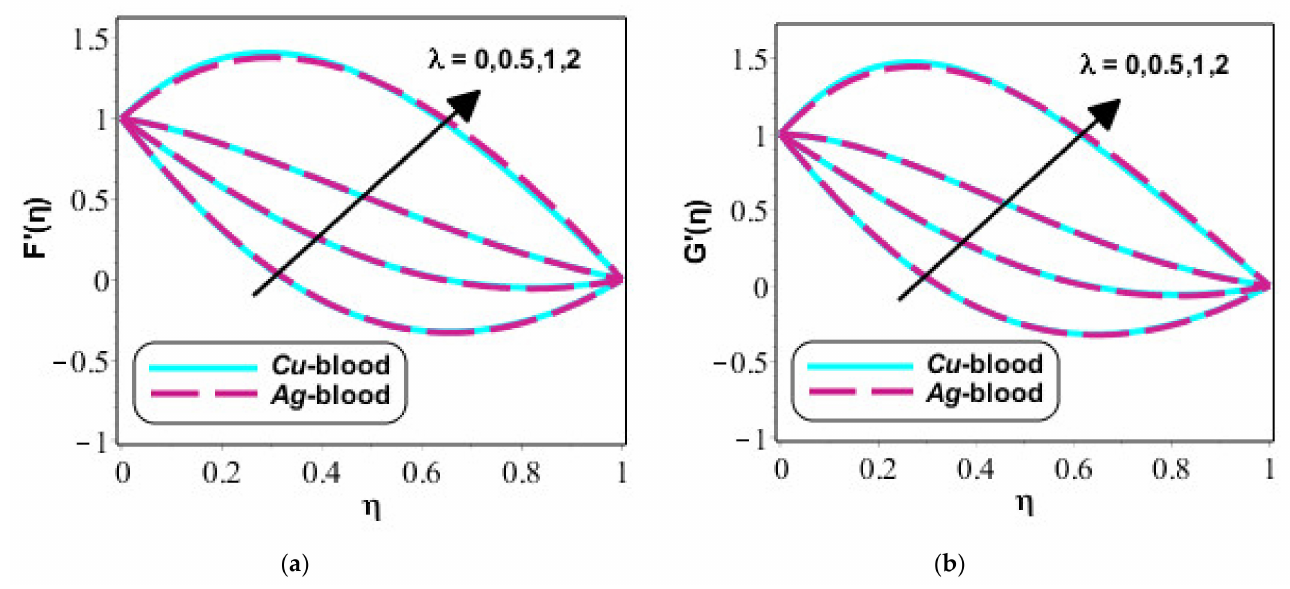
Figure 5. Behaviour of ( a ) F (cid:48) ( η ) and ( b ) G (cid:48) ( η ) as varying λ when φ = 0.1, Re = 5, β i = 1.5, β e = 2, M = 5.